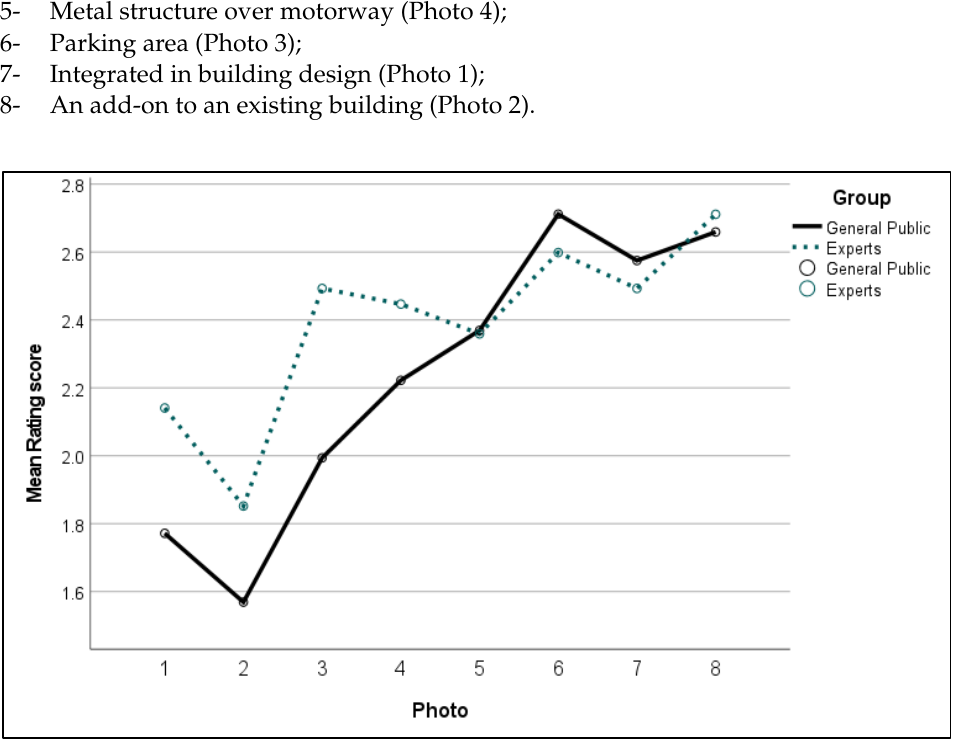
Figure 6. Overall mean rating scores provided by experts and the public for each